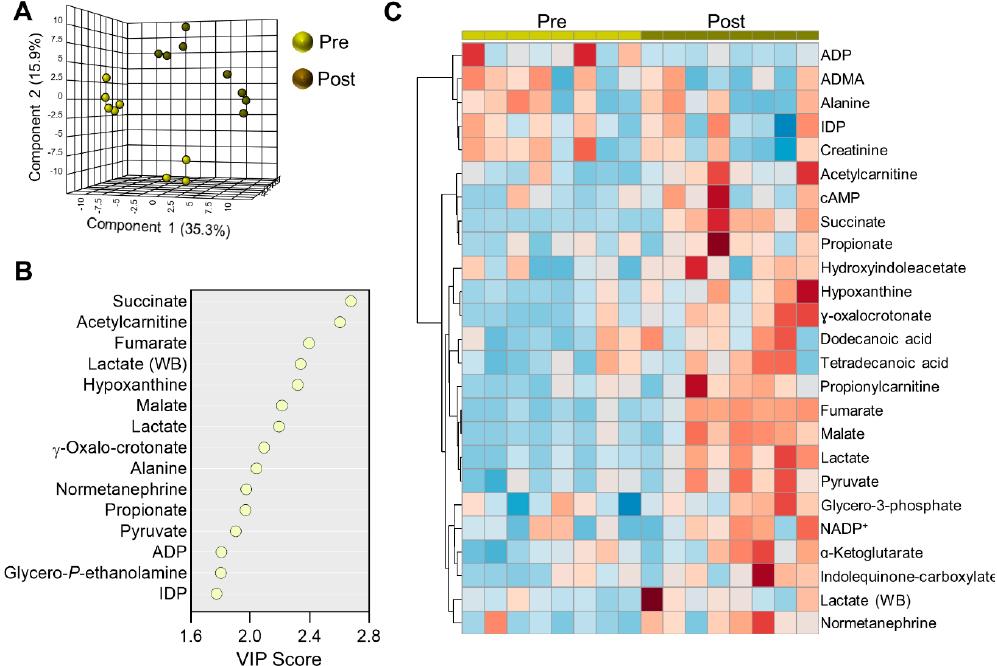
Figure 3. Plasma metabolomics. ( A ) Partial least-squares discriminant analysis (PLS-DA) of the plasma fraction isolated from cyclists before (Pre) and after (Post) a 30 min cycling test. ( B ) The top 15 metabolites ranked by variable importance in projection (VIP) of the PLS-DA are plotted. ( C ) Hierarchical clustering analysis showing the top 25 significant metabolites by t -test.